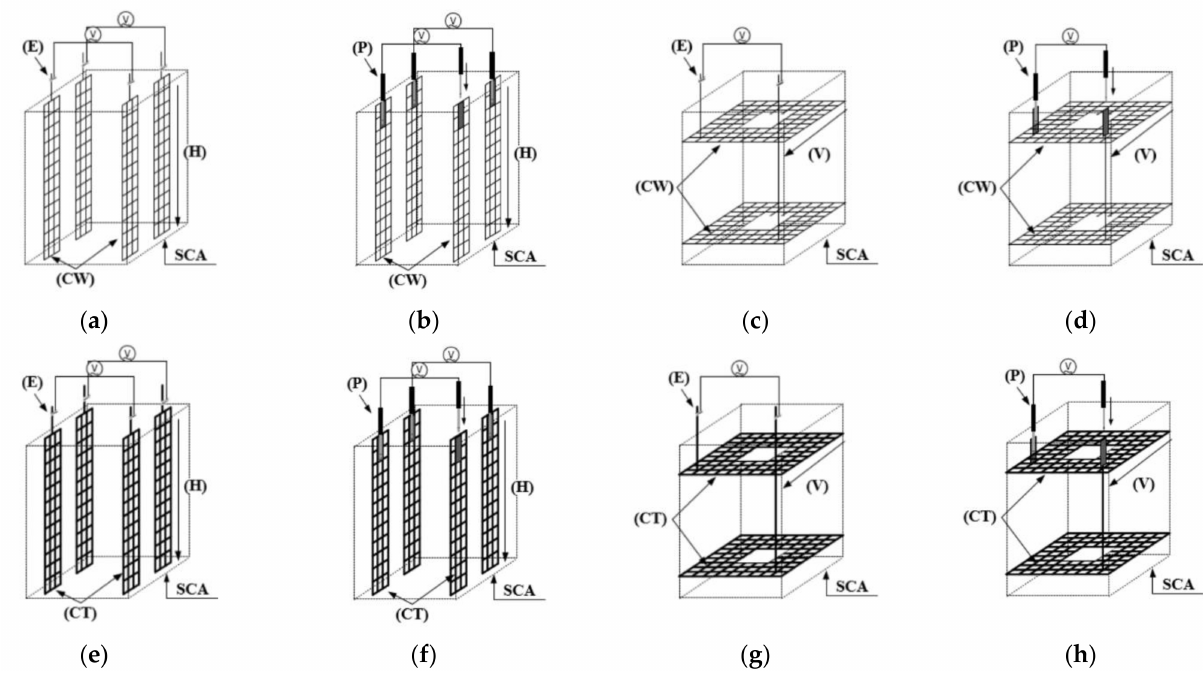
Figure 4. Electrode types for smart concrete anchorage: ( a ) CW-H-E; ( b ) CW-H-P; ( c ) CW-V-E; ( d ) CW-V-P, ( e ) CT-H-E; ( f ) CT-H-P, ( g ) CT-V-E; ( h )